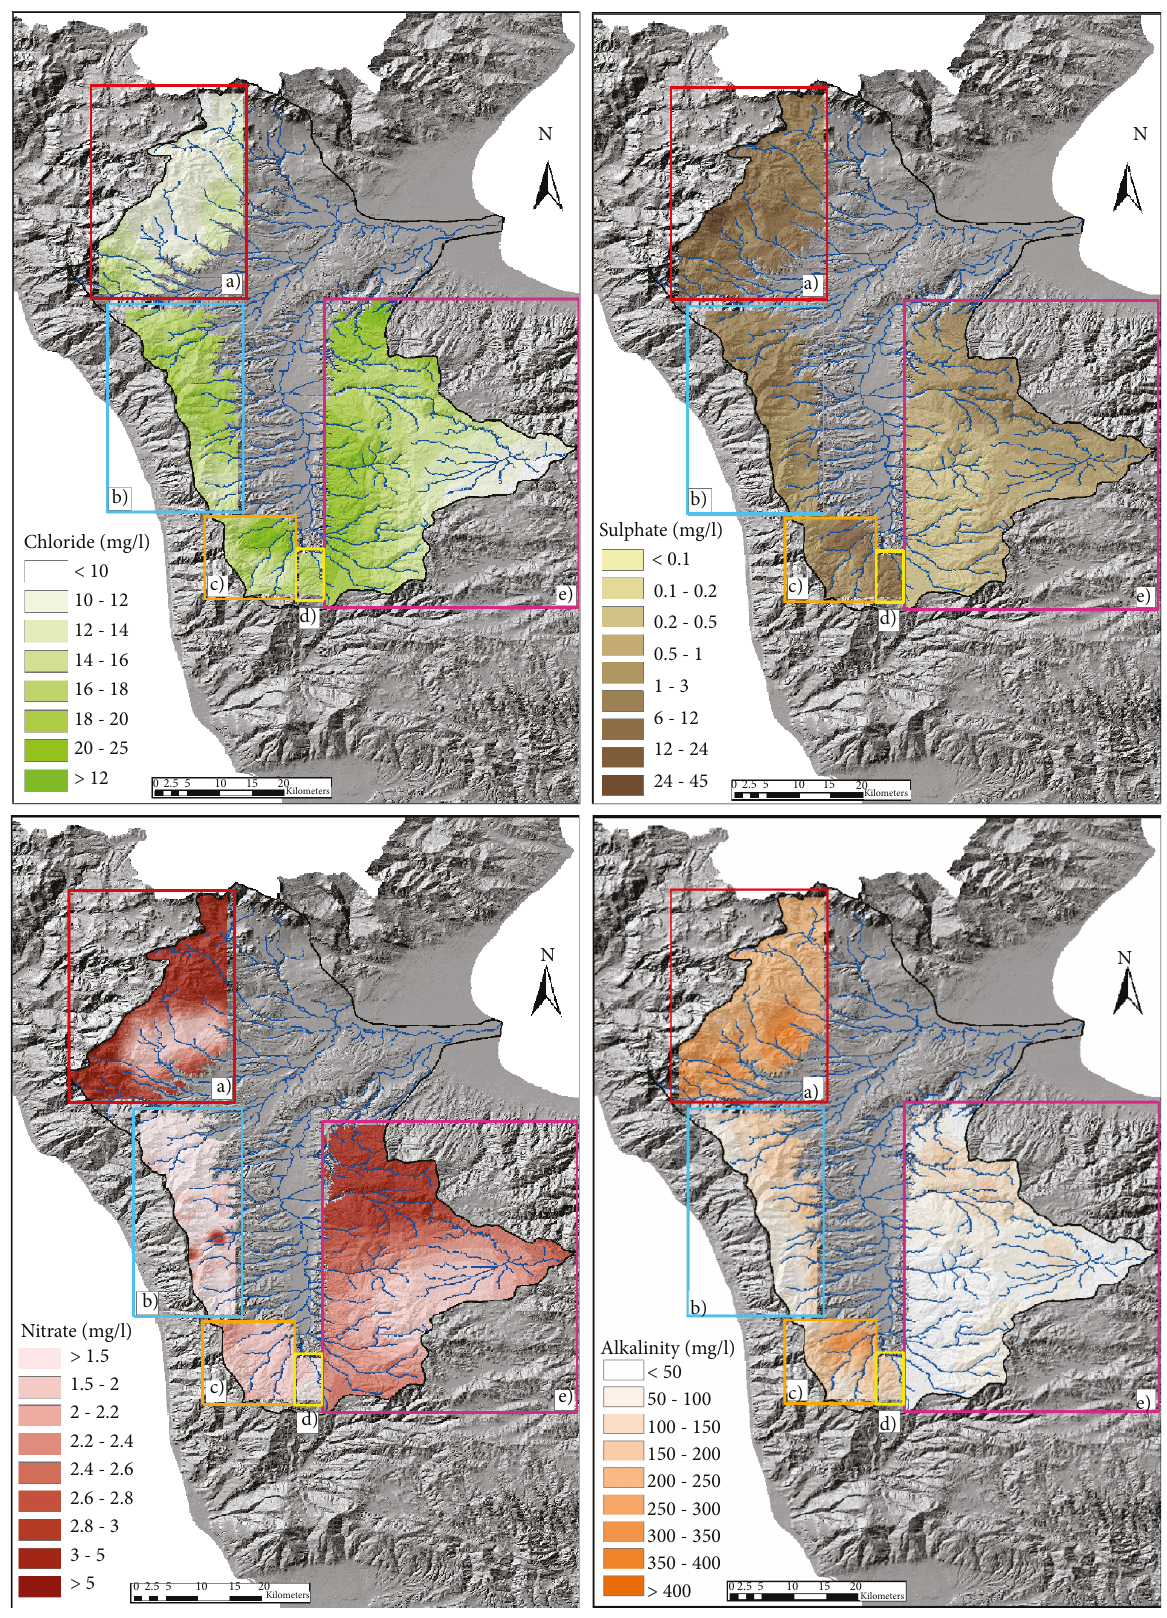
Figure 7: Spatial distribution of chloride, sulphate, nitrate and alkalinity in waters from the 5 subareas of the Crati river